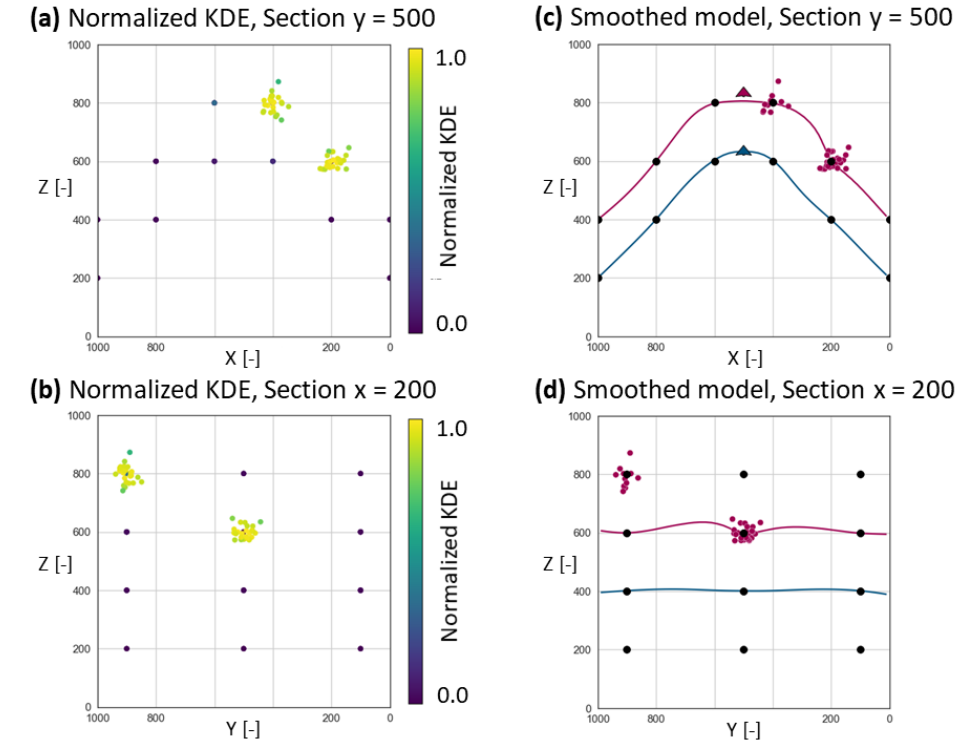
Figure 9. Geomodel of a folded unit. Two clusters of 25 noisy data points were added to the data from model in Figure 5. ( a , b ) Sections with normalized KDE of surface point input data. ( c , d ) Sections of resulting model with KDE informed local smoothing. Note that input data are projected on section